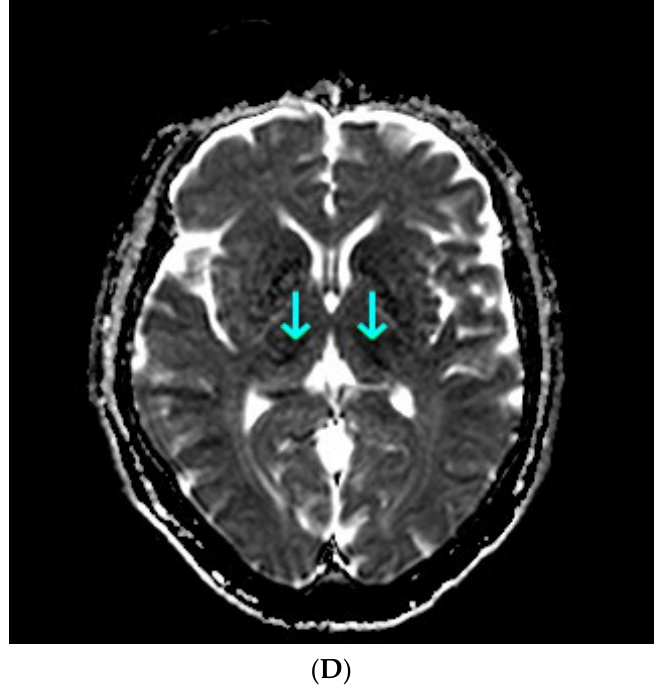
Figure 1. ( A ) Magnetic resonance imaging of the head. T1 Spin Echo, axial. Green arrows point to hyper-intense globi pallidi; ( B ) Magnetic resonance imaging of the head. T2 Turbo Spin Echo Dark-fluid. Red single arrows point to the mild symmetric hyper-intensity in the insulas; double red arrow point to the pronounced hyper-intensity in the left occipital lobe; ( C ) Magnetic resonance imaging of the head. Diffusion Weighted Imaging b = 1000, axial. Cyan arrows point to the restricted water diffusion in both thalami; ( D) Magnetic resonance imaging of the head. Apparent Diffusion Coefficient, b = 0, b = 1000, axial. Cyan arrows point to the restricted water diffusion in both thalami.